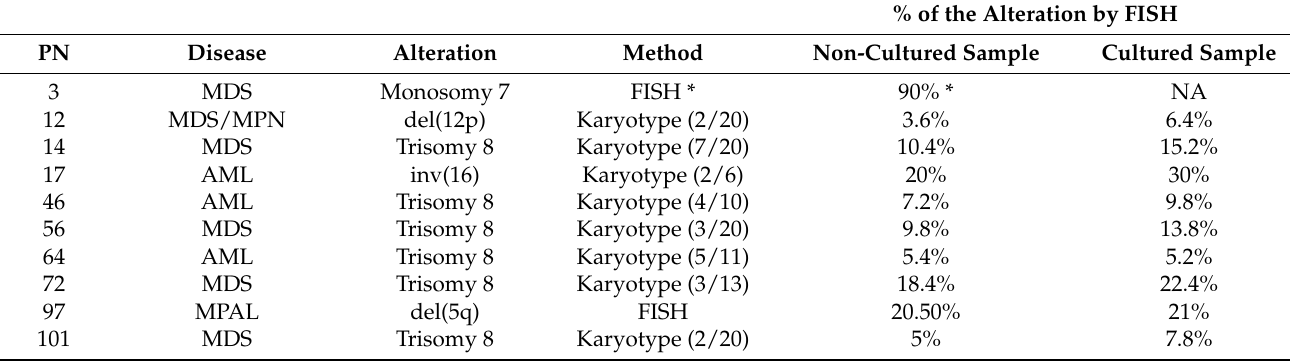
Table 1. Alterations observed only by cytogenetics.